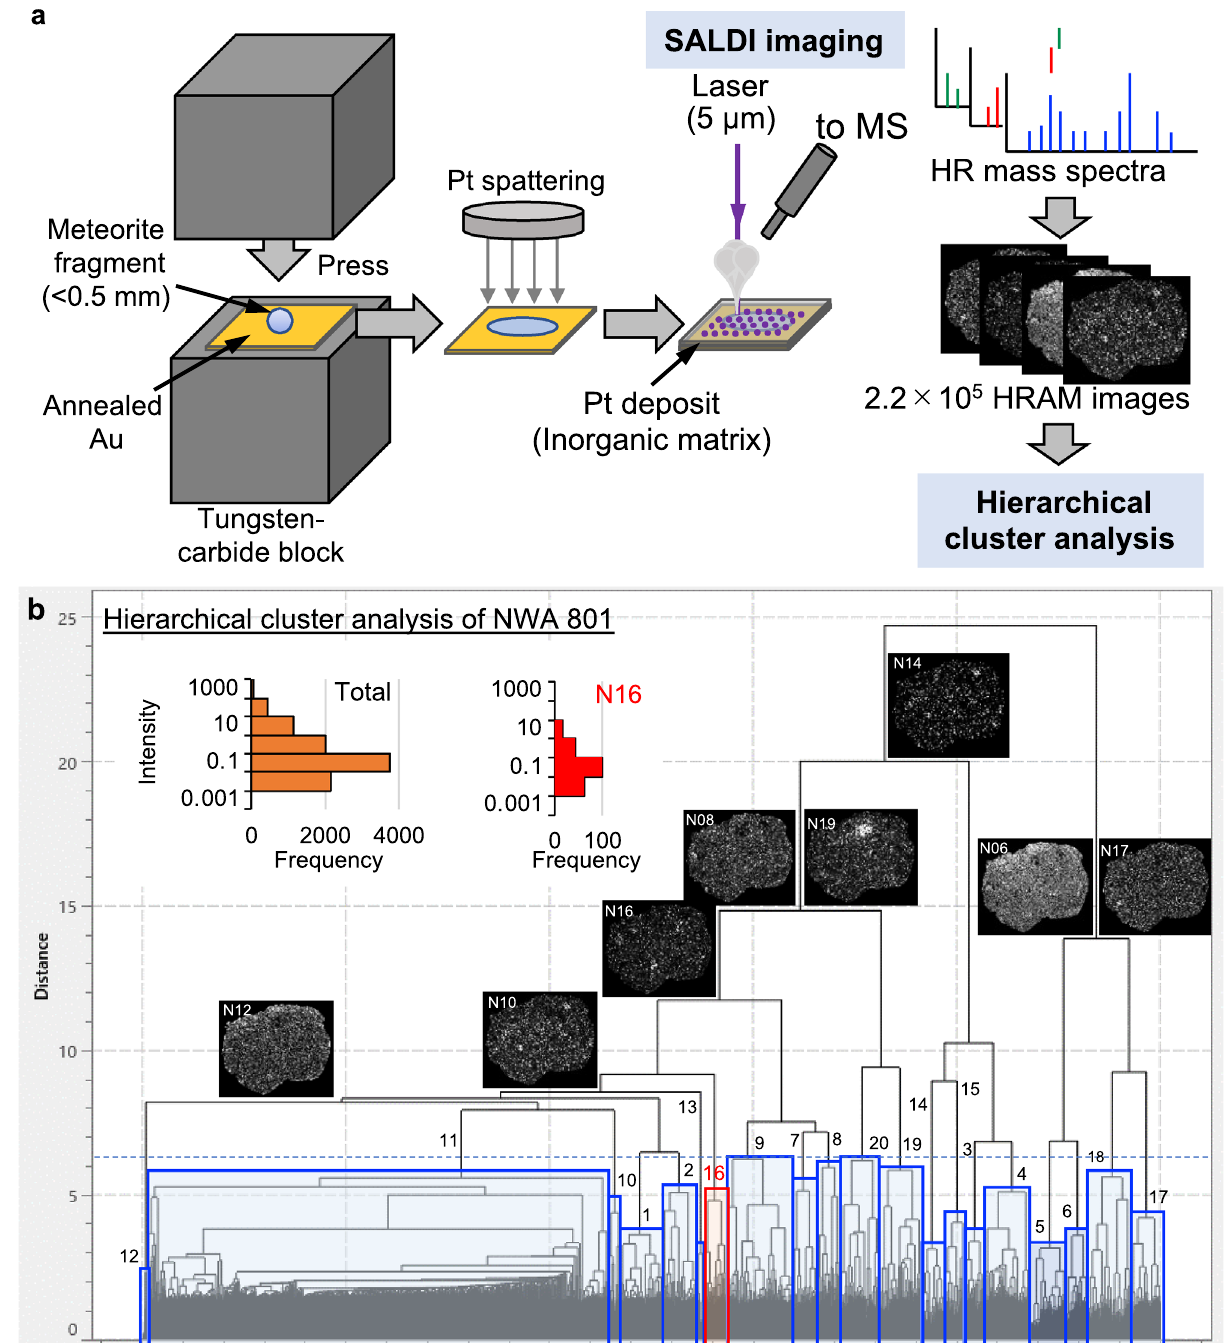
Figure 1. Pt-SALDI imaging and hierarchical cluster analysis of NWA 801 meteorite. ( a ) Pt-SALDI imaging of meteorite. Pt inorganic matrix was sputtered on a compressed meteorite fragment. The sample was analyzed by a SALDI system connected to a high mass resolution mass spectrometer. Distributions of 2.2 × 10 5 signals were constructed using spot-by-spot high-resolution accurate mass (HRAM) signals. ( b ) Hierarchical cluster analysis of major signals detected in the NWA 801 meteorite. The similarity in the spatial distribution of signals was categorized into 20 clusters. The relative dissimilarity of spatial distributions between the clusters is represented by the distance of the horizontal bar between the